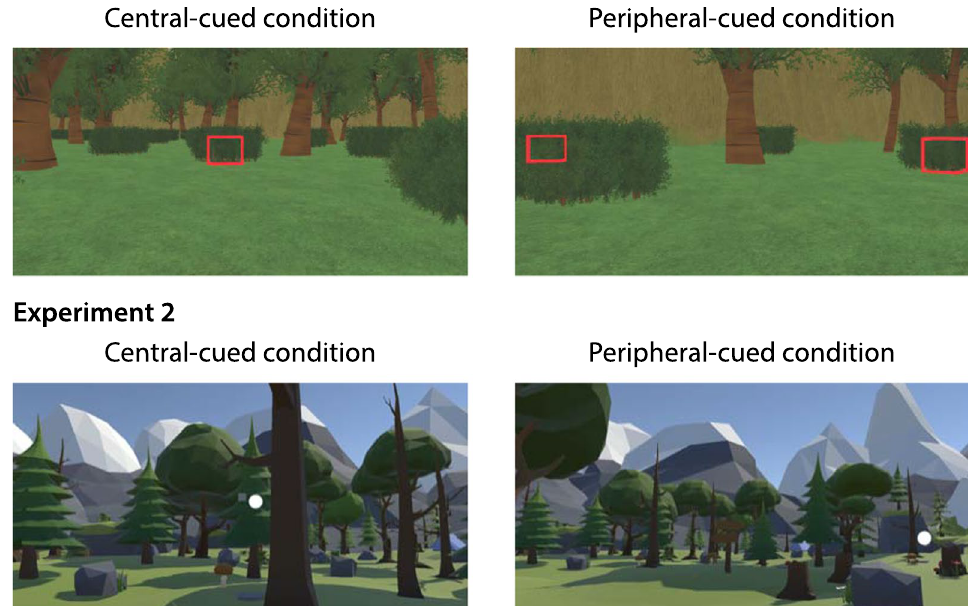
Fig. 1 Screenshots from the central-cued and peripheral-cued conditions of Experiment 1 (top) and Experiment 2 (bottom). In Experiment 1, subjects navigated in a virtual environment to find targets chests that were obscured by bushes. The chests were sometimes highlighted in red depending on their position and the attentional cueing condition. In the central-cued condition (top left), targets were highlighted when their direction was within 10° of the central direction and less than 50 m away. In the peripheral-cued condition (top right), targets were highlighted when they were at least 40° to the left or right of the center and less than 50 m away. In Experiment 2, subjects passively viewed simulated movement through an environment while performing dot-probe task. In the central-cued condition (bottom left), the superimposed dots appeared within 5° of the center of the display. In the peripheral-cued condition (bottom right), the dots appeared in an annulus between 20 and 30° from the center